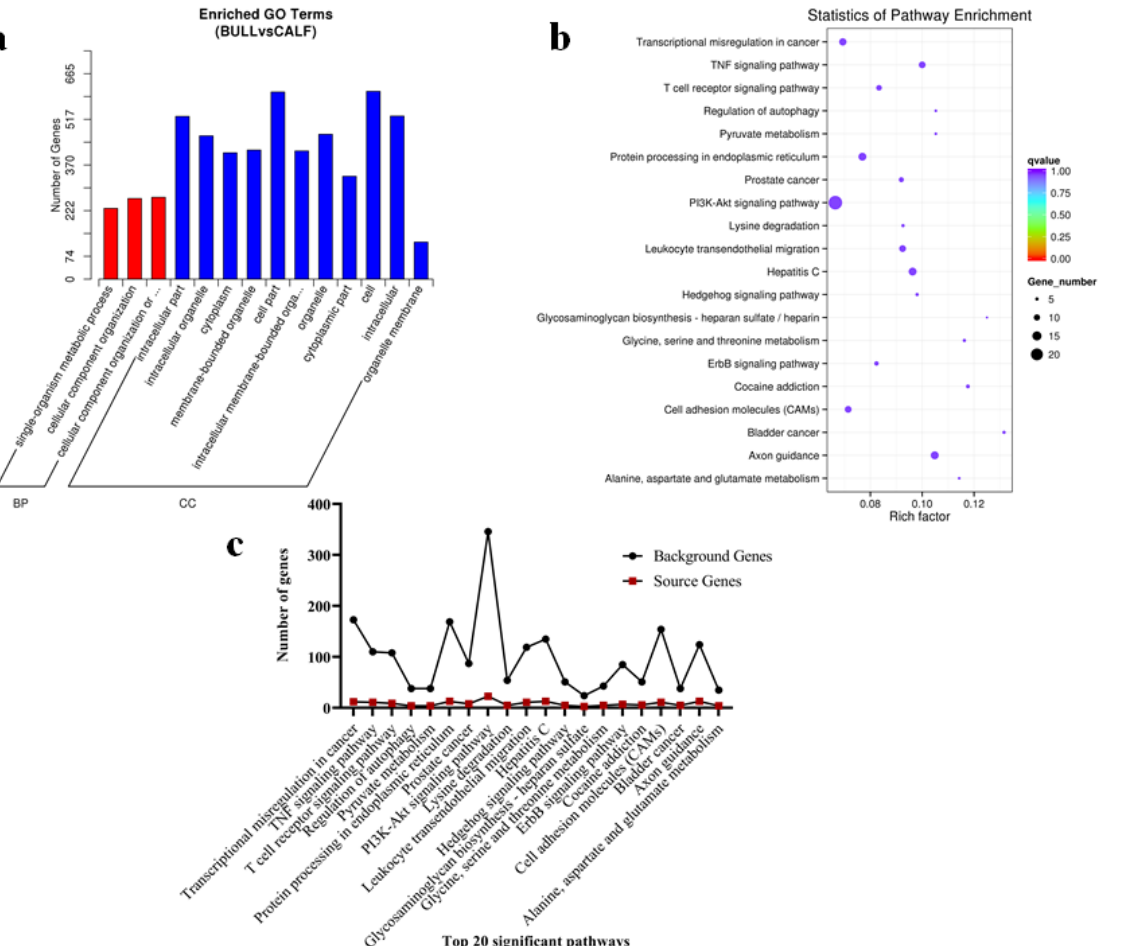
Figure 7. GO analysis and KEGG functional validation of DE miRNAs were highlighted. ( a ) The X-axis depicts the GO descriptions, while the Y-axis depicts the number of candidate genes identified in GO terms. The GO classifications are showing the two colored sections, as biological processes (red color) and cellular components (blue color). ( b ) Top-20 KEGG enriched pathways map of DE miRNAs linked genes in testicular samples. The vertical line shows the significant pathway names while horizontal line shows enrichment factors. ( c ) The top-20 signaling pathways represent the complete background genes and source